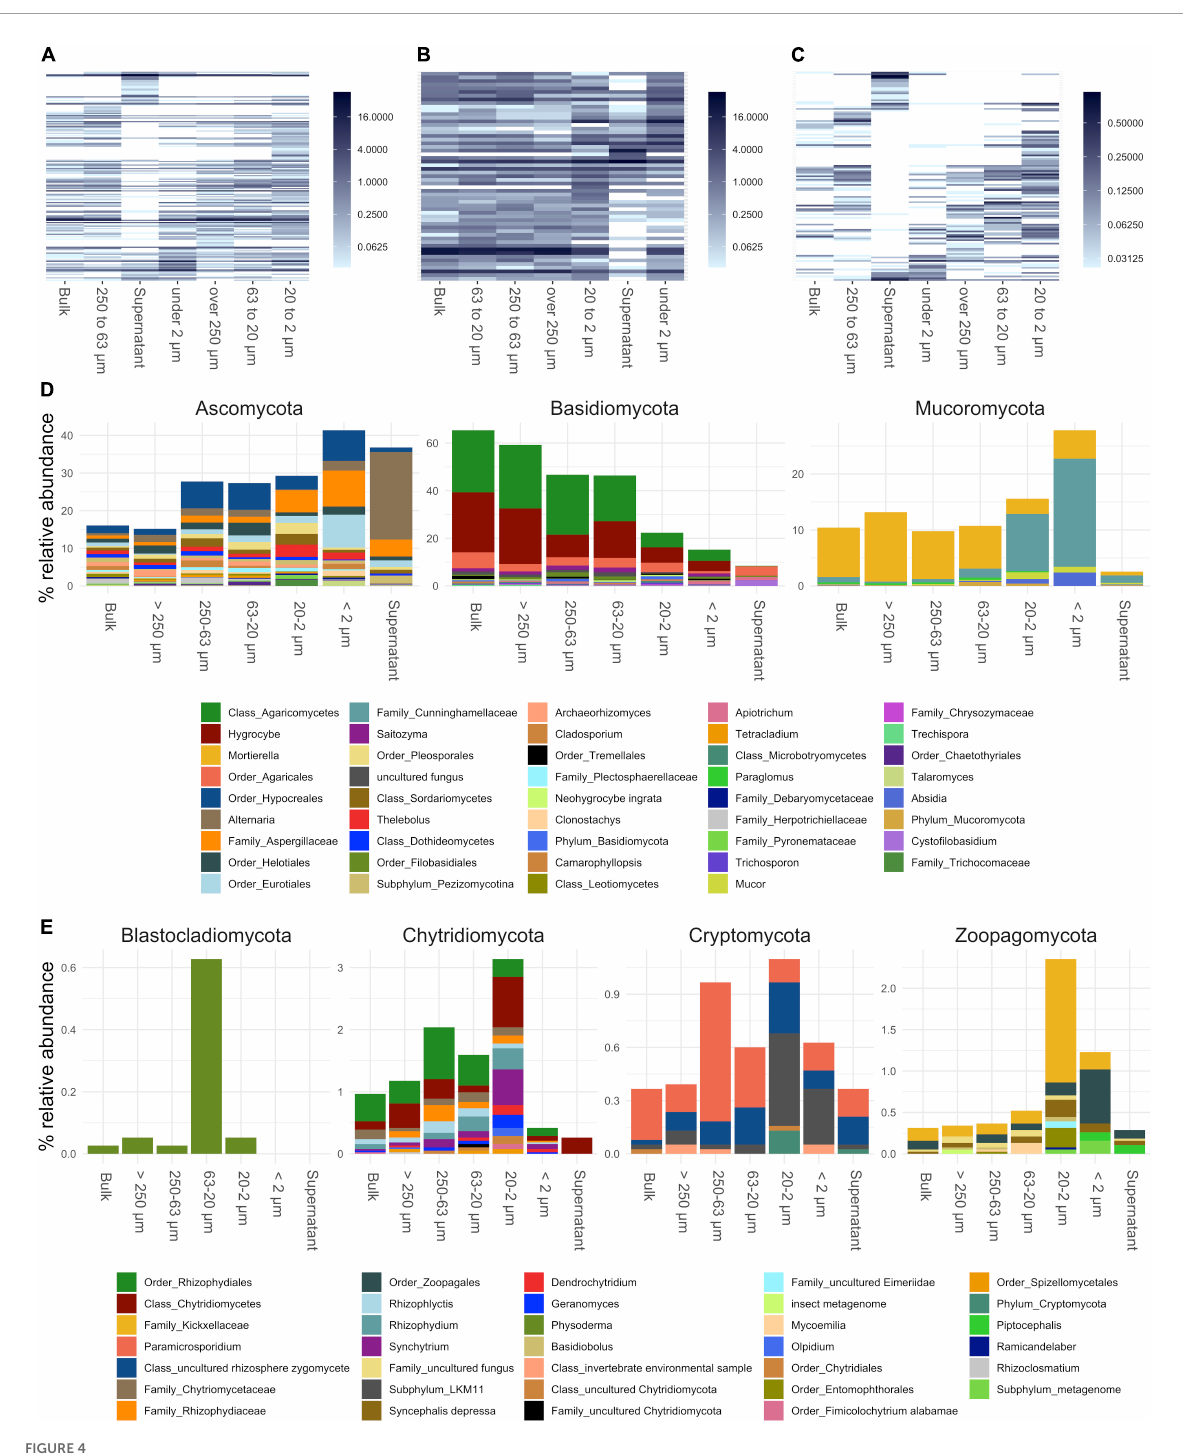
FIGURE4 Annotated fungal amplicon sequence variants (ASVs) of small subunit (SSU) rRNA gene amplicons collapsed to genus level. (A–C) Show heatmaps of all genera detected, genera present over and under 1% in relative abundance, respectively. Order of x and y-axis of heatmaps are based on a PCoA ordination of unweighted unifrac distances. (D) Bar plots of higher abundant phyla showing genera over 0.2% in relative abundance. (E) Bar plots of lower abundant phyla (unfiltered). If taxa unit could not be annotated at the genus level the name of the last higher rank where an annotation at a bootstrap value of 0.8 was possible is